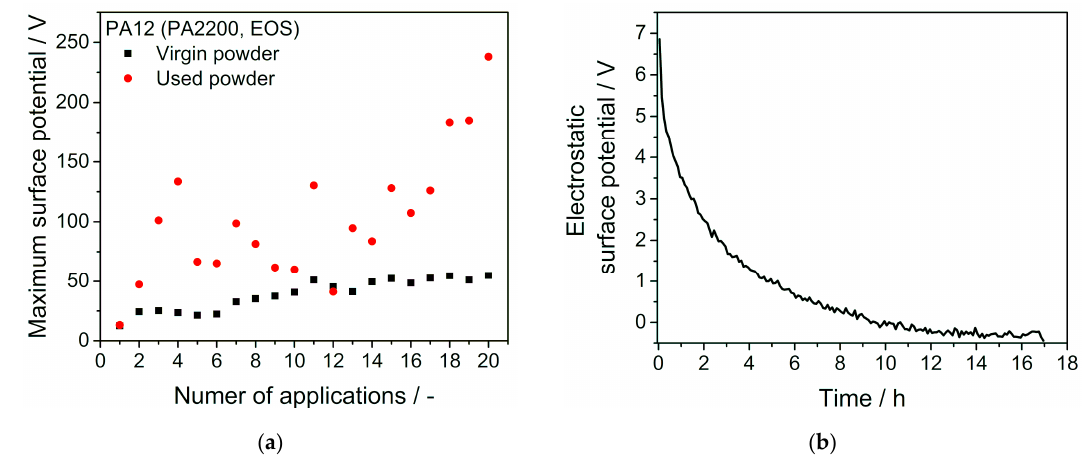
Figure 3. ( a ) Maximum surface potential measured for a high number of repeated applications of virgin and used PA12 powders. ( b ) Relaxation of the electrostatic surface potential over time. Voltmeter probe has not been moved relatively to the powder layer in this measurement. Experiment has been conducted at 30% relative humidity.